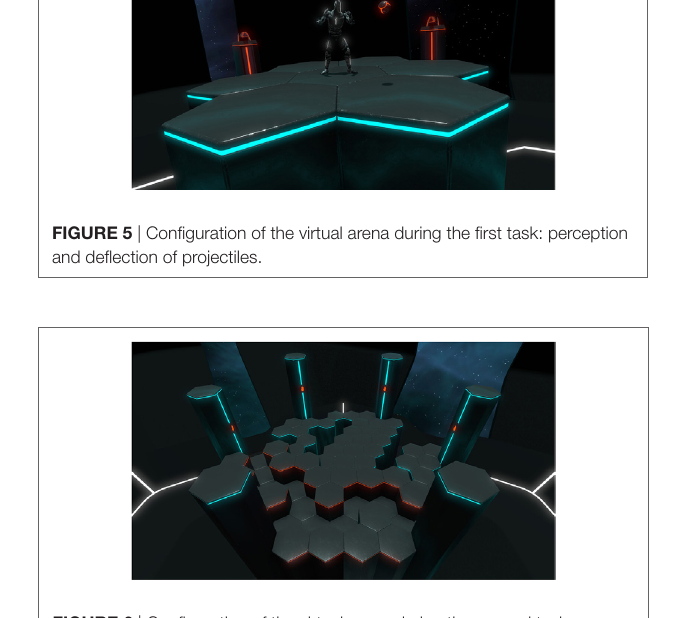
FigUre 6 | Configuration of the virtual arena during the second task: navigation and interaction with